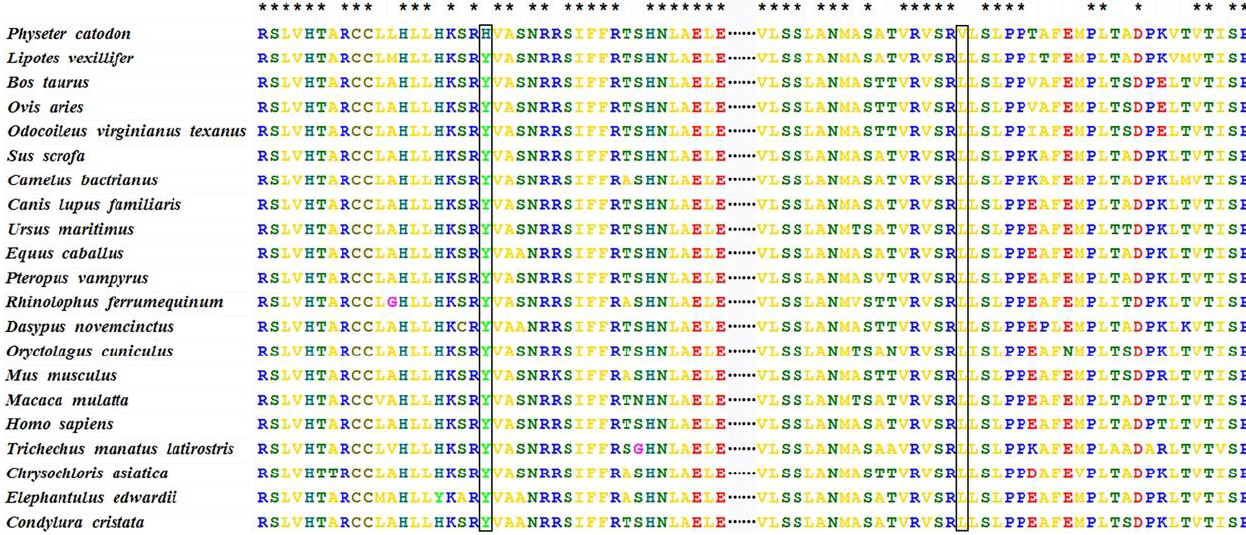
Figure 4. Two sperm-whale-specific missense mutations found in LIPE. The missense mutations are marked within rectangles, and the asterisk means that all species have the same amino acid type at this position.